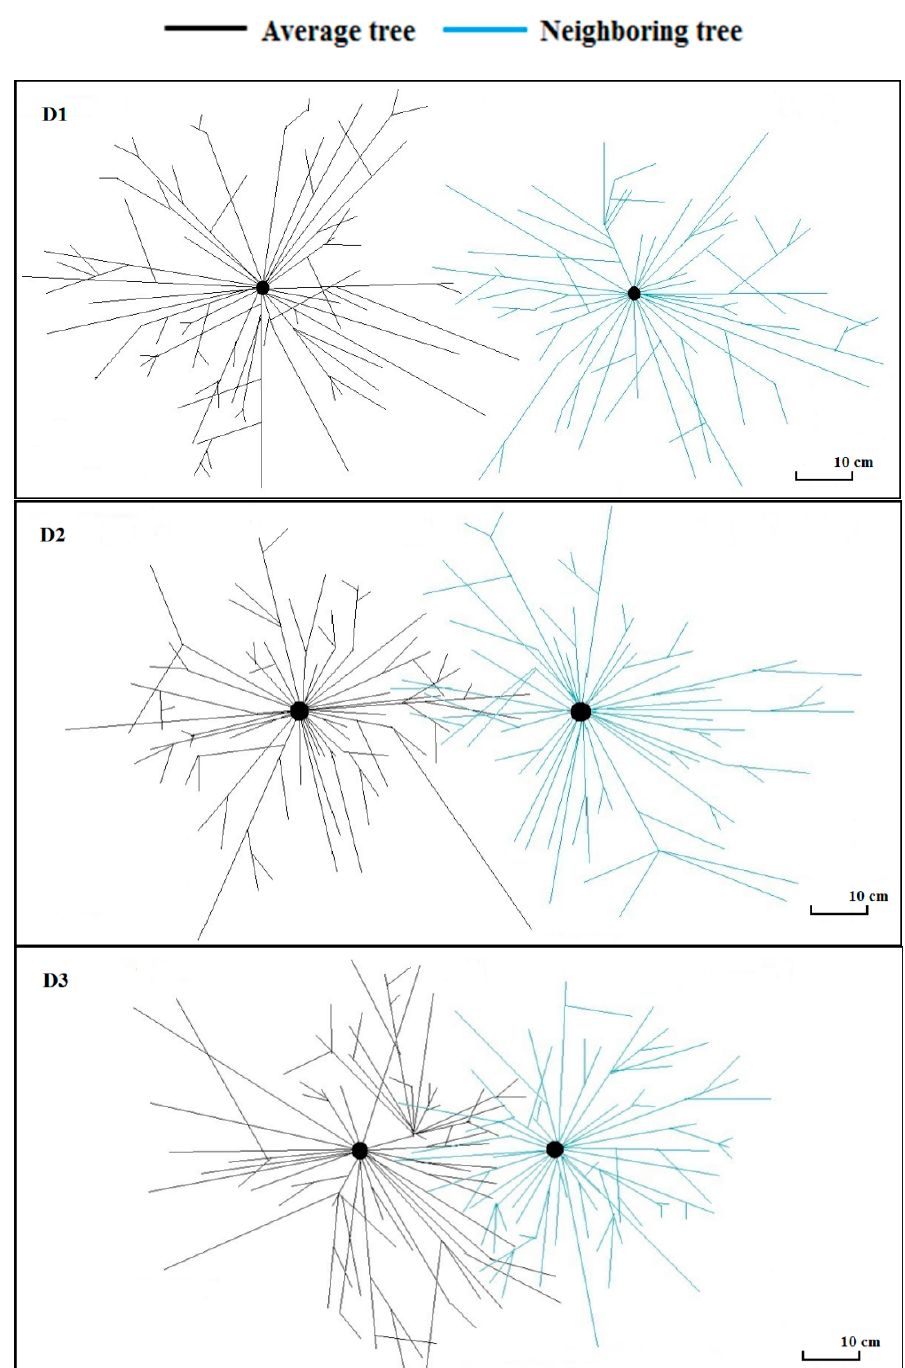
Figure 7. Top view of the root structure of average tree and neighboring tree in low (D1), intermediate (D2) and high stand density (D3) configurations of Chinese fir.